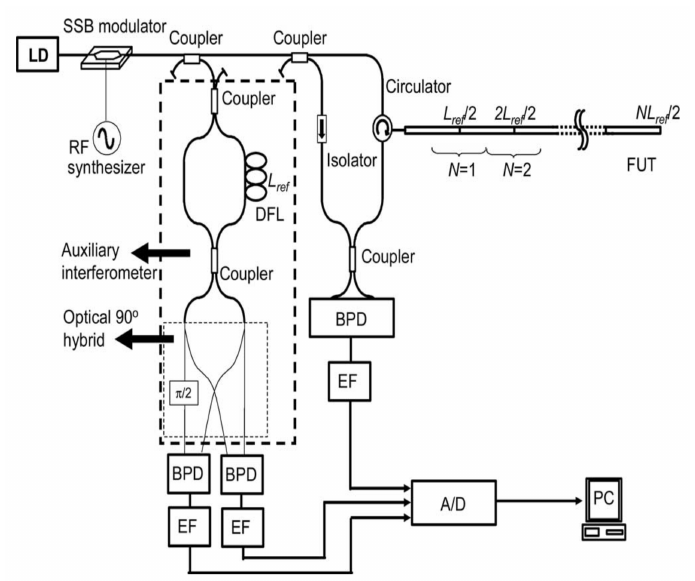
Figure 7. Experimental setup for CGPs nonlinear phase compensation method SSB is single